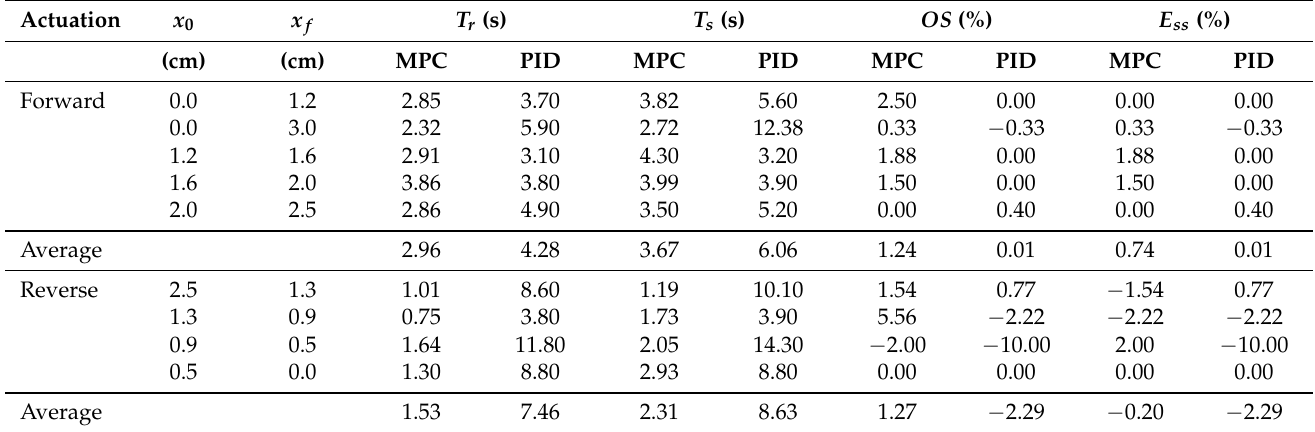
Figure 13. Comparison between SMPC and GSPID staircase tracking. Table 6. Comparison between SMPC and GSPID staircase tracking